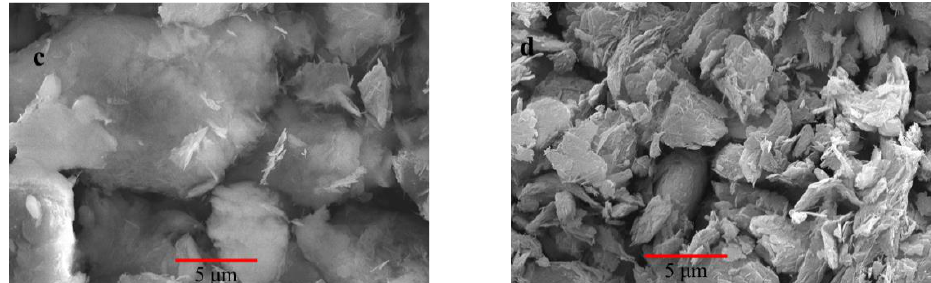
Figure 3. SEM image of original sepiolite ( a ) and modified sepiolite ( b ) in the literature [2].